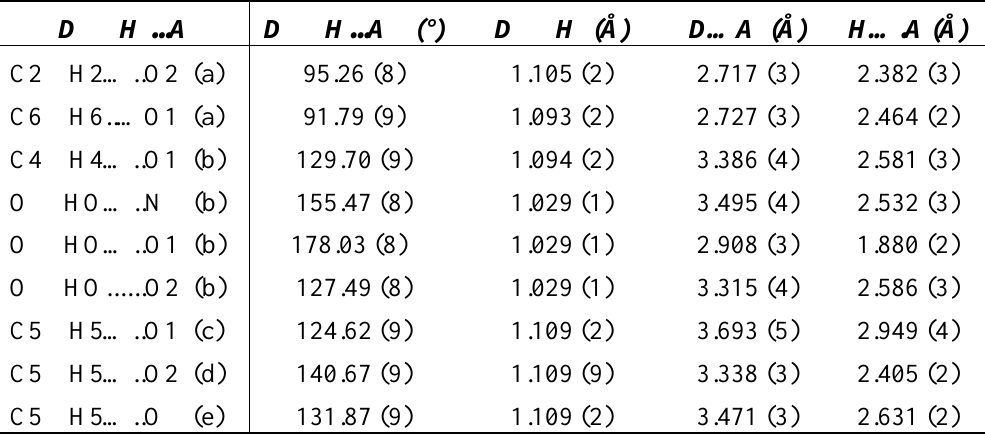
Figure 7. Deformation density map in the plan of the hydrogen bond; Contour map is 0.05 eÅ -3 Table 5. Various possible hydrogen